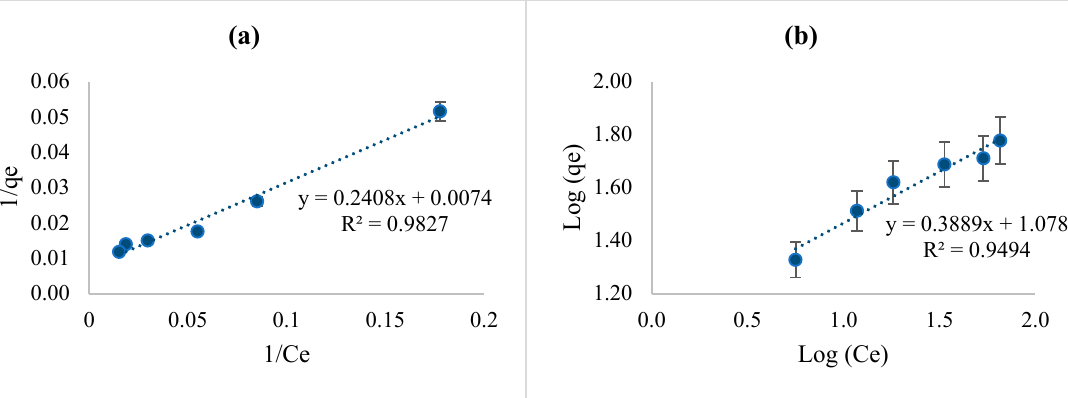
Figure 15. ( a ) Langmuir isotherm of ebony hair dye onto COZ, and ( b ) Freundlich isotherm of ebony hair dye onto COZ.